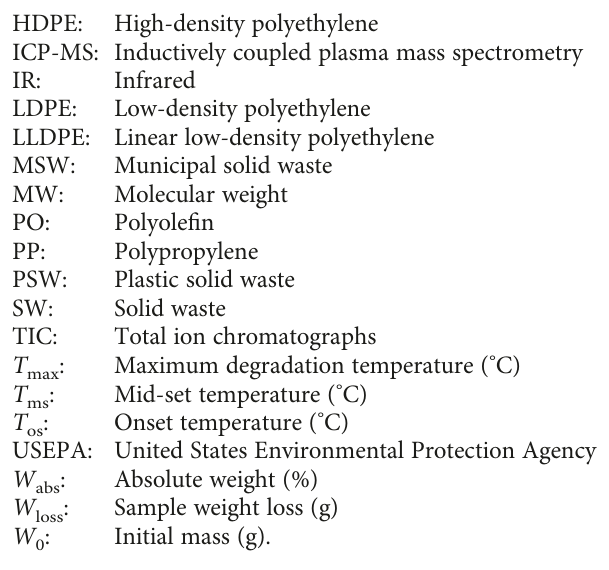
of text. Figure S1: standard specimen size used ( fi lm dimen- sions: 20 × 1 cm). Figure S2: TG-IR apparatus for evolved gas analysis. Figure S3: pictorial depiction of the soil burial site used in this work. Figure S4: FTIR spectra obtained for the three analysed plastic bags with the reference nondegrad- able PE bag showing in sequential order from top to bottom, type II, type I, type III, and reference PE bag. Figure S5: DSC thermograms of all three sample bags showing the 2nd heat cycle along with the basic thermal properties. Figure S6: Gram-Schmidt graphs for the tested samples along with the reference PE material. Figure S7: TGA experimental thermo- grams obtained from the three sample types and the refer- ence PE sample. Figure S8: IR spectra for the evolved gases showing both decomposition steps. Figure S9: IR spectra for